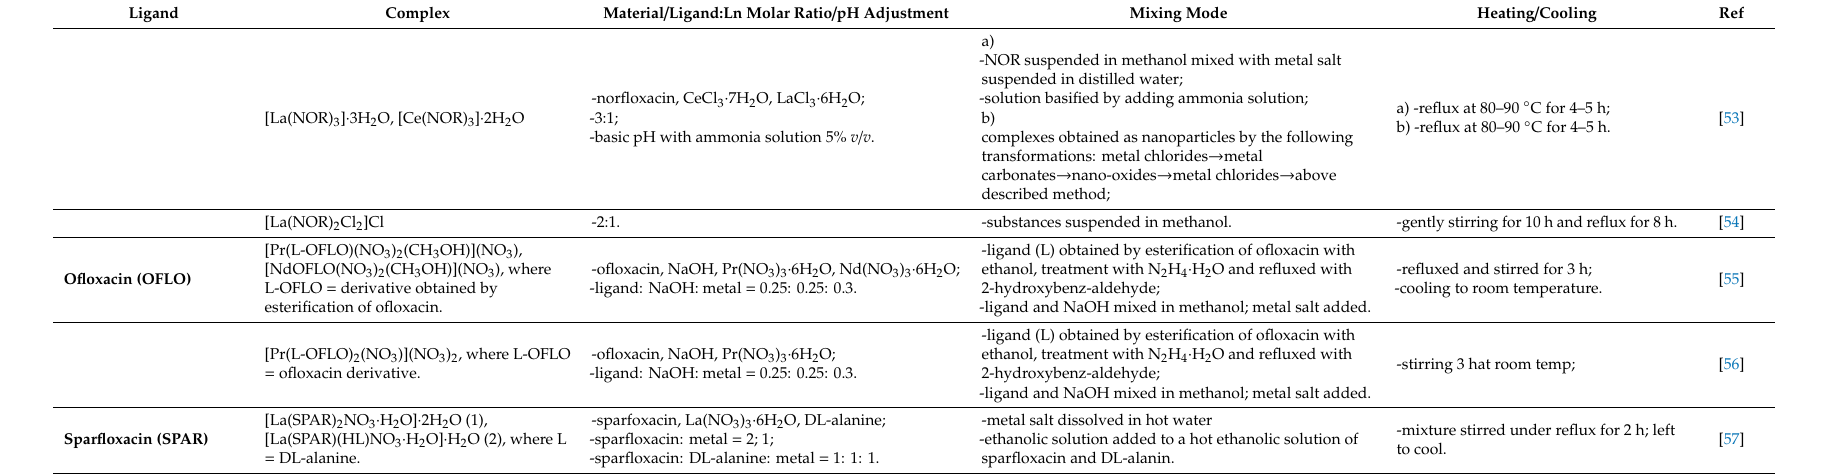
-sparfloxacin: DL-alanine: metal = 1: 1: 1.